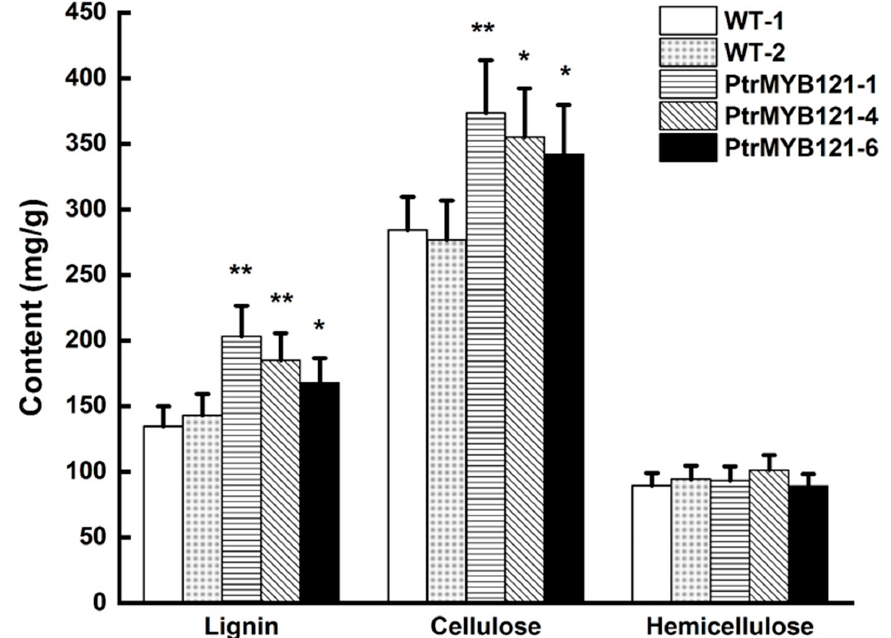
Figure 5. Content of SCW components (lignin, cellulose, and hemicellulose) in the inflorescence stems of WT and PtrMYB121 -overexpressing transgenic Arabidopsis. Error bars represent ± SD from three biological repeats. Significant difference between different lines was tested by Student’ s t-test. * p < 0.05 and ** p < 0.01.